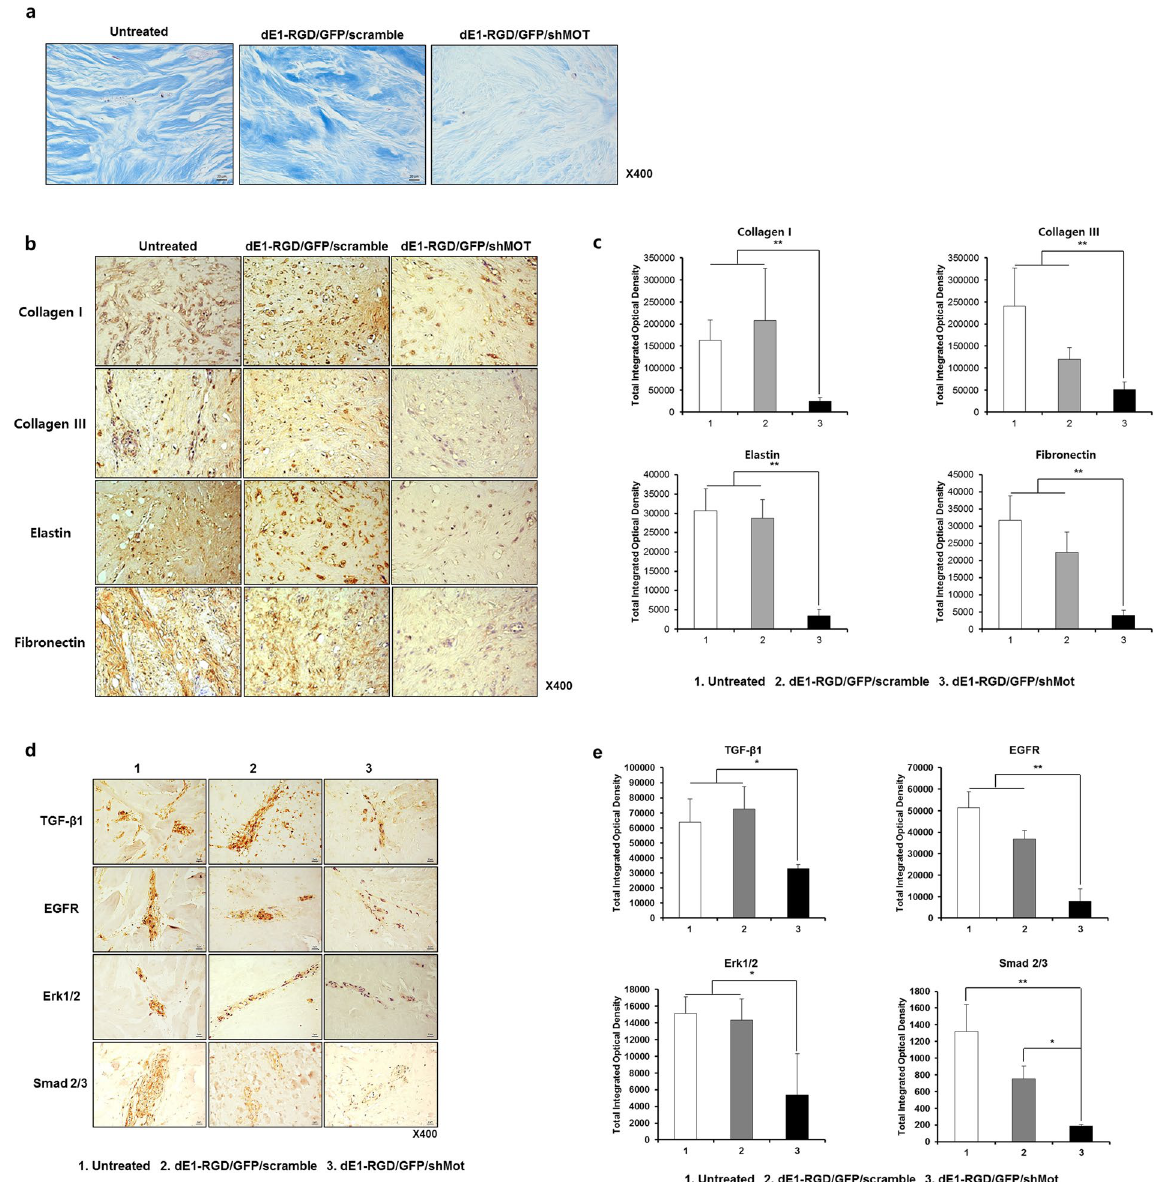
Figure 4. Immunohistochemical staining of type I and III collagen, elastin, and fibronectin protein from dE1- RGD/GFP/shMot-transduced keloid spheroid tissues. ( a ) Masson’s trichrome staining of keloid spheroids. After dEl-RGD/GFP/shMot treatment of keloid spheroids, dense and coarse collagen bundles were replaced with thin and shallow collagen bundles. Original magnification: x400. ( b ) Reduced expression of ECM components including collagen type I and III, elastin, and fibronectin protein in keloid spheroids transduced with dE1-RGD/ GFP/shMot compared to those in spheroids transduced with scramble virus. Original magnification: 400x. ( c ) Semi-quantitative image analysis for type I and III collagen, elastin, and fibronectin protein expression. Significant reduction in type I collagen, type III collagen, elastin, and fibronectin was observed in keloid spheroids transduced with dE1-RGD/GFP/shMot in comparison to untreated group or scramble virus- treated virus ( ** p < 0.01). ( d ) Reduced expression of TGF- β 1, EGFR, Smad 2/3 complex, and Erk 1/2 protein in primary keloid spheroids by mortalin specific shRNA-expressing adenovirus (x400). ( e ) The decreased expression of TGF- β 1, EGFR, Smad 2/3 complex, and Erk 1/2 were observed in mortalin specific shRNA- expressing adenovirus treated keloid spheroids, by 52%, 43%, 11%, and 42%, respectively, versus scramble virus- transduced spheroids ( * p < 0.05, ** p <